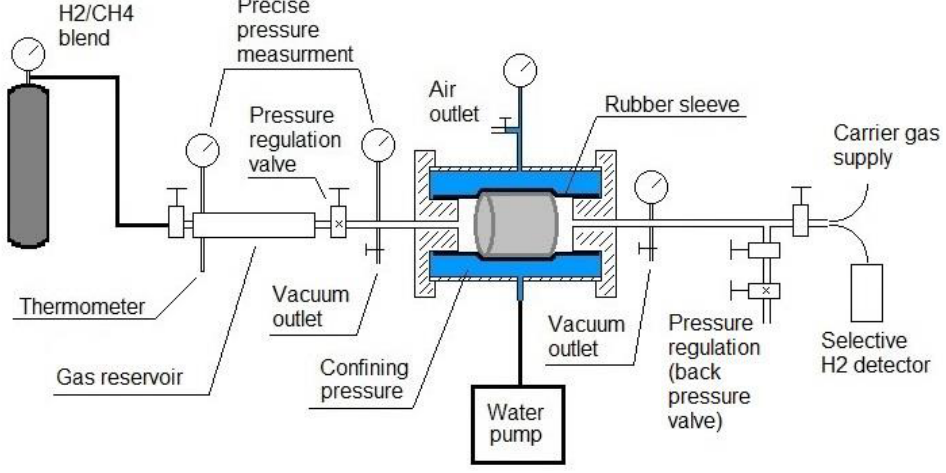
Figure 2. Steady-State Method/Carrier Gas Method setup.